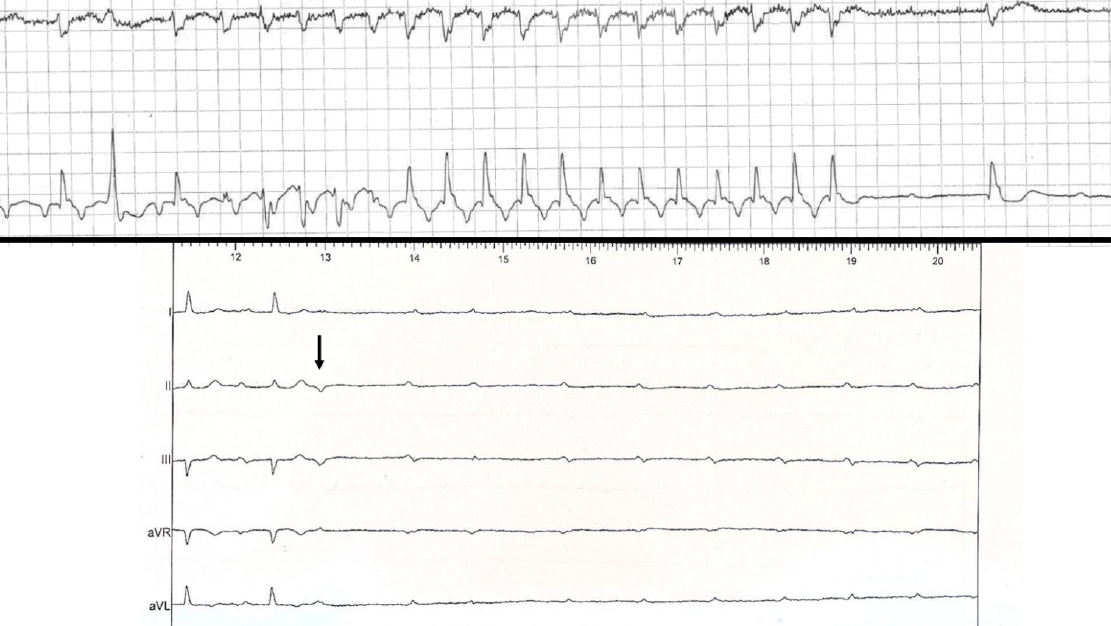
Figure 4. Example of two other mechanisms of pause-dependent atrioventricular blocks. The telemetry strips show a counterclockwise isthmus-dependent flutter termination followed by PD-AVB (upper panel). In the same patient (11 from Table 2), another episode could be recorded, induced by a premature ventricular contraction. Surface ECG showed a PD-AVB episode induced by a His extrasystole (arrow) as shown by the retrograde P wave visible (lower panel). A blocked premature atrial contraction may not be ruled out (patient 13 in Table 2).